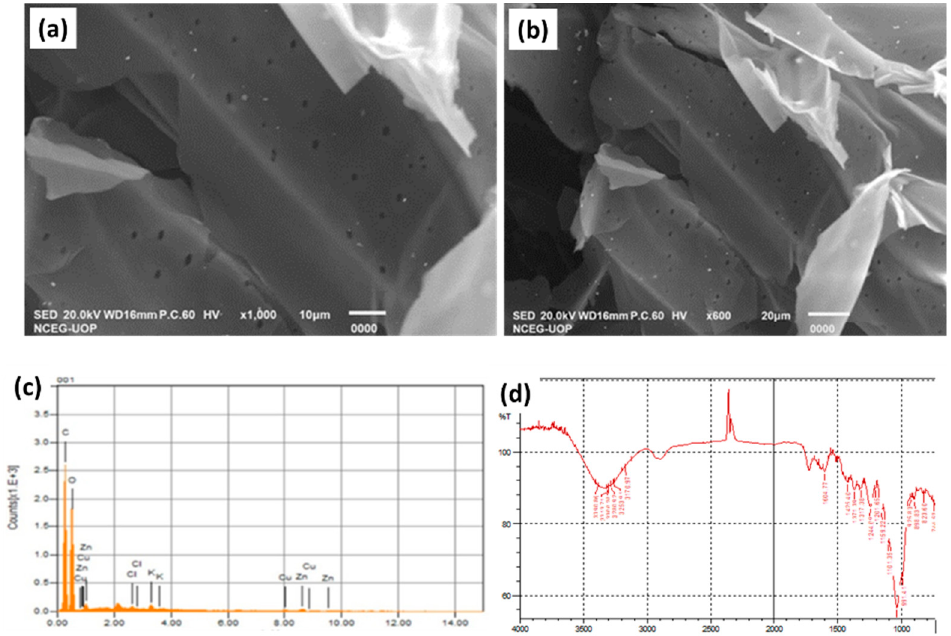
Figure 1. ( a , b ) SEM ( c ) EDX ( d ) FTIR spectrum of sugarcane bagasse (SCB).